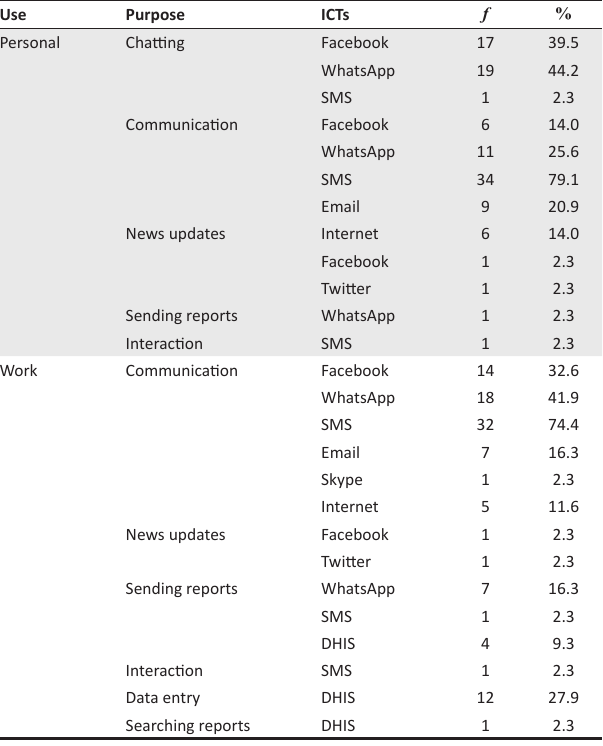
TABLE 3: Use of information and communication technology applications in personal and work spaces ( n =